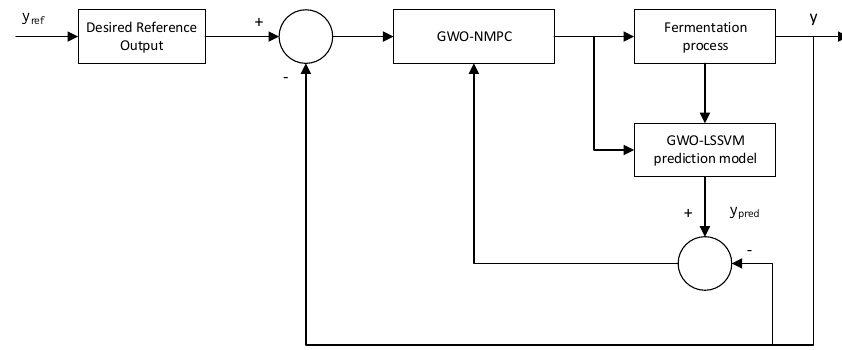
Figure 3. GWO-LSSVM-NMPC to control L -Lysine product